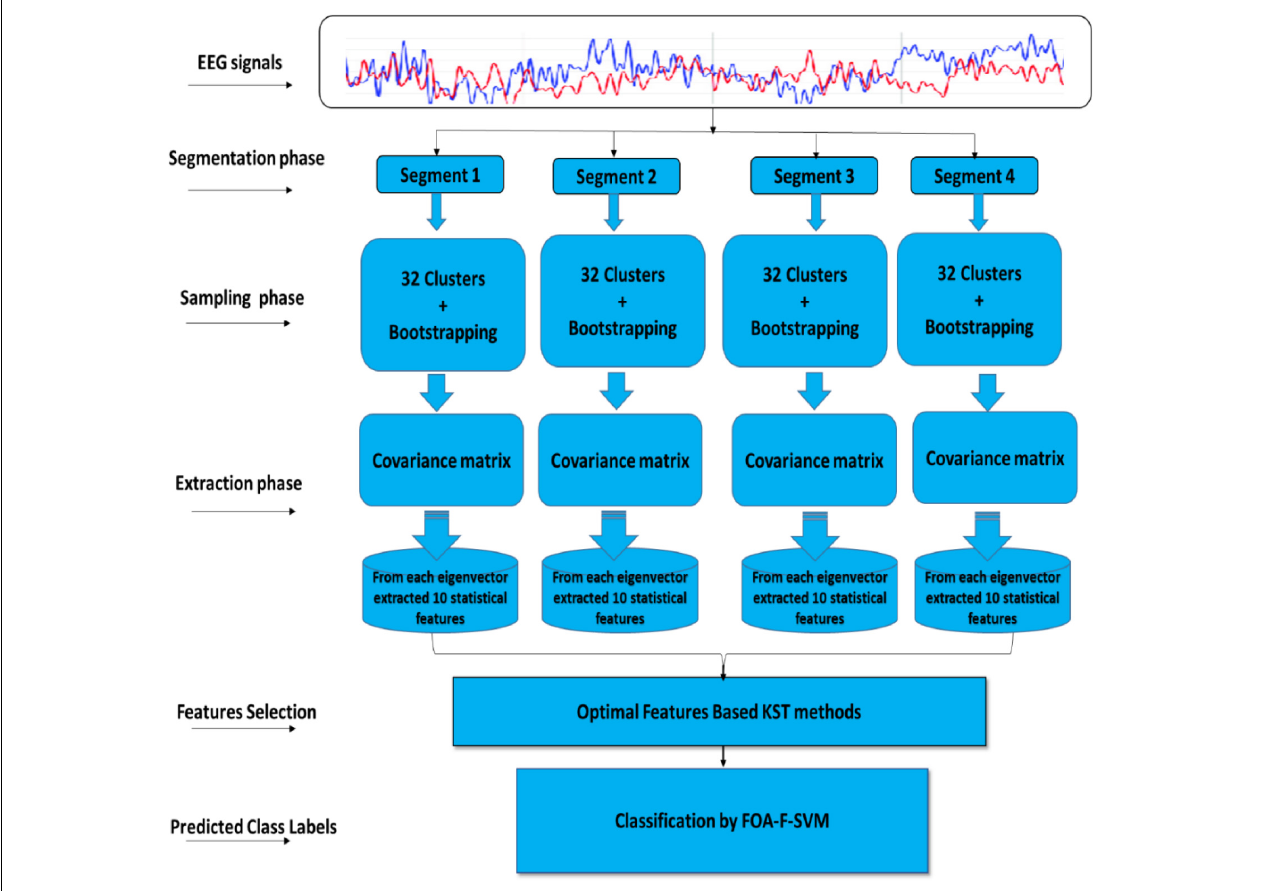
FIGURE 1 | A flow diagram representation of the algorithm developed for detection and classification of alcoholism-based EEG